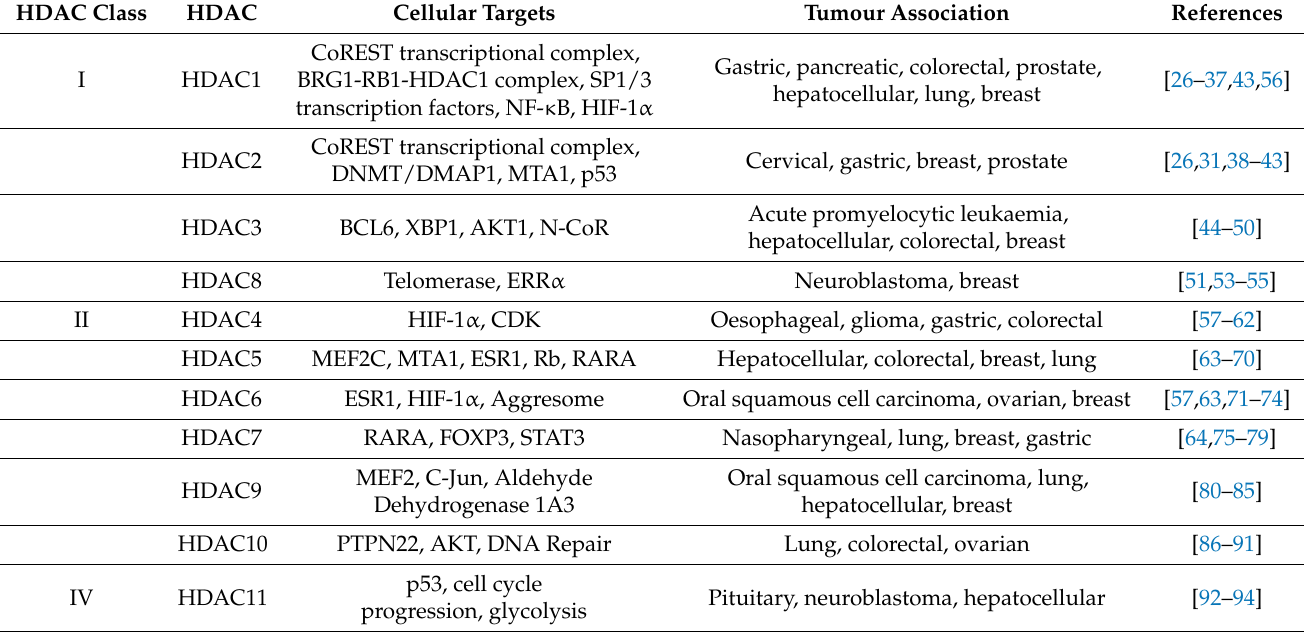
Table 1. Cellular targets of HDACs and associations with tumour